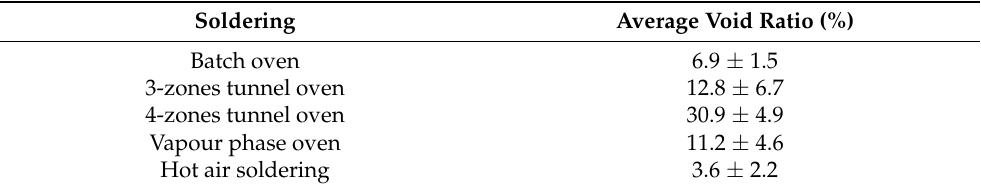
Figure 8. X-ray images of the solder joints under the IGBT: ( a ) batch oven, ( b ) 3-zones tunnel oven, ( c ) 4 zones tunnel oven, ( d ) vapour phase oven, ( e ) hot air soldering. Table 2. Voids percentage